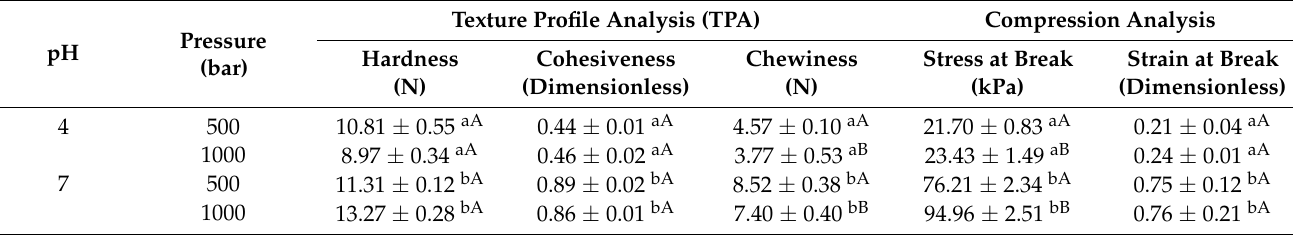
Table 3. Textural properties of emulsion gels stabilized by